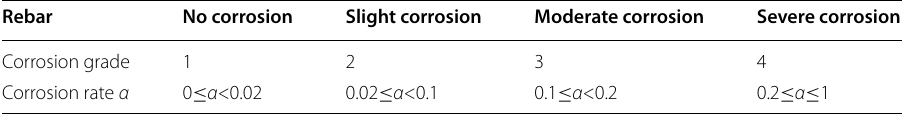
Table 3 Classification of corrosion degree α of steel bars Rebar